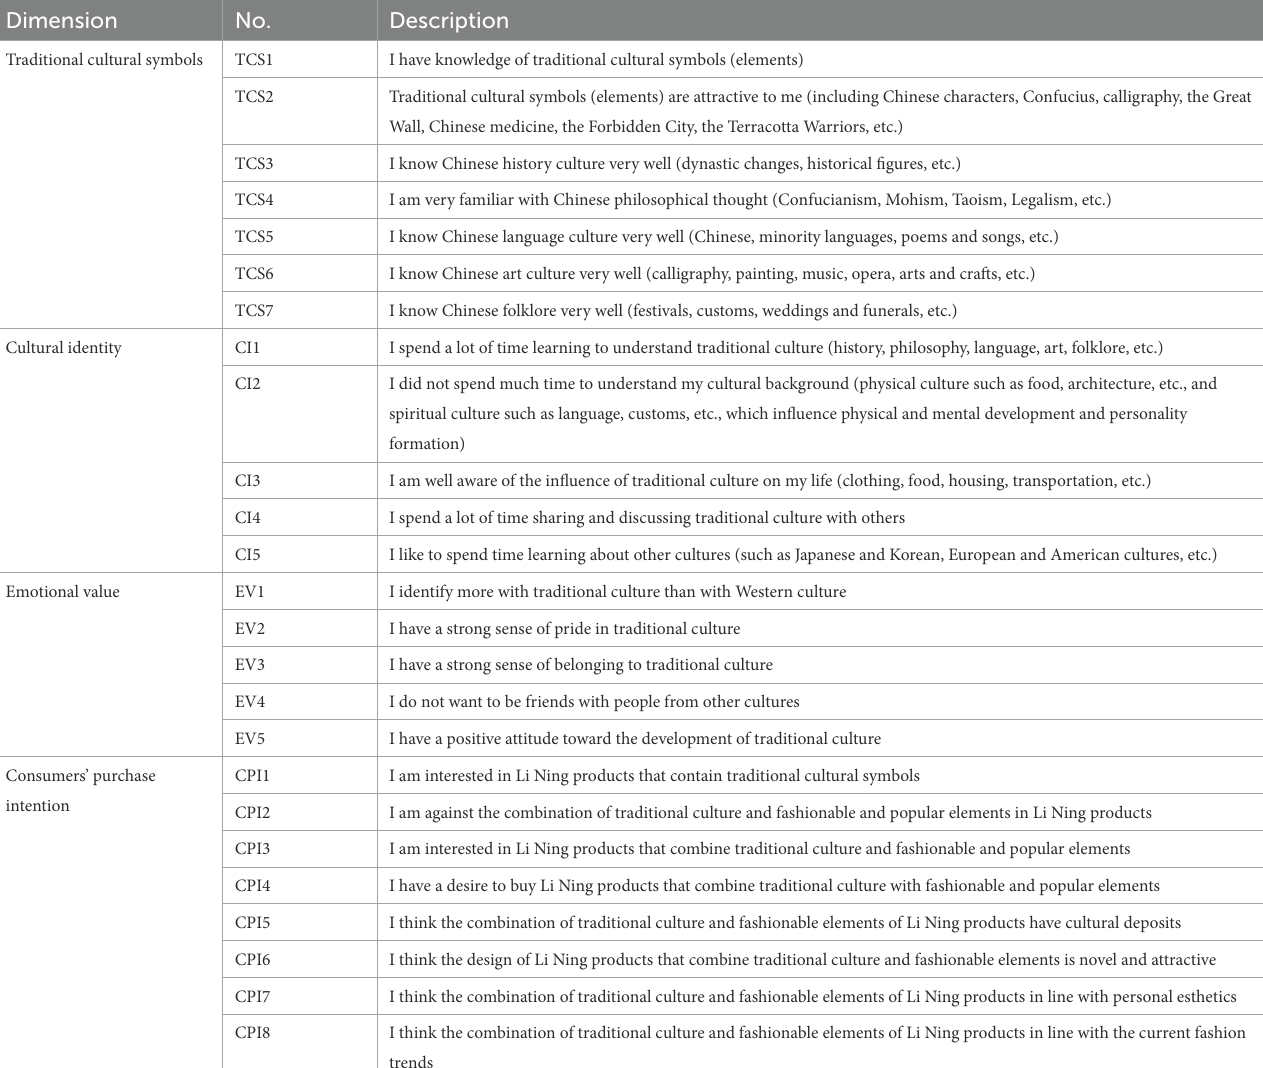
TABLE 2 Measurement items. Dimension No. Description Traditional cultural